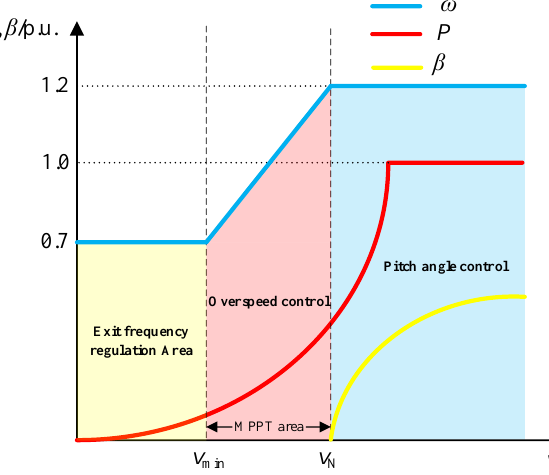
Figure 2. The range of wind power primary frequency control.